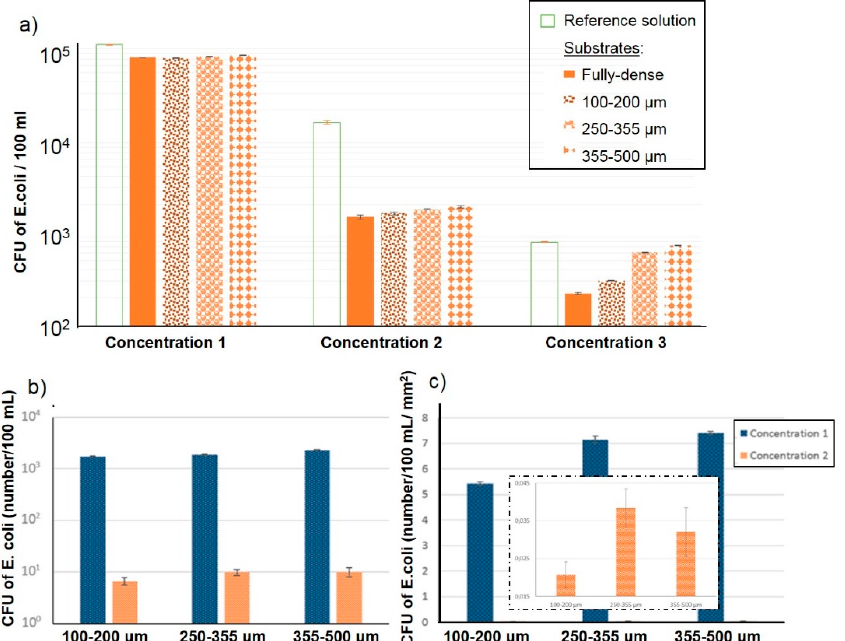
Figure 5. Bacteria quantification following protocols described (P1, P2, and P3). ( a ) CFU of E. coli bacteria after membrane filtration (Protocol 1), CFU of E. coli bacteria inside the pores measured following Protocol 3: ( b ) absolute values and ( c ) normalized values by the inner pores surface. Inset: magnification view of the concentration view for the normalized